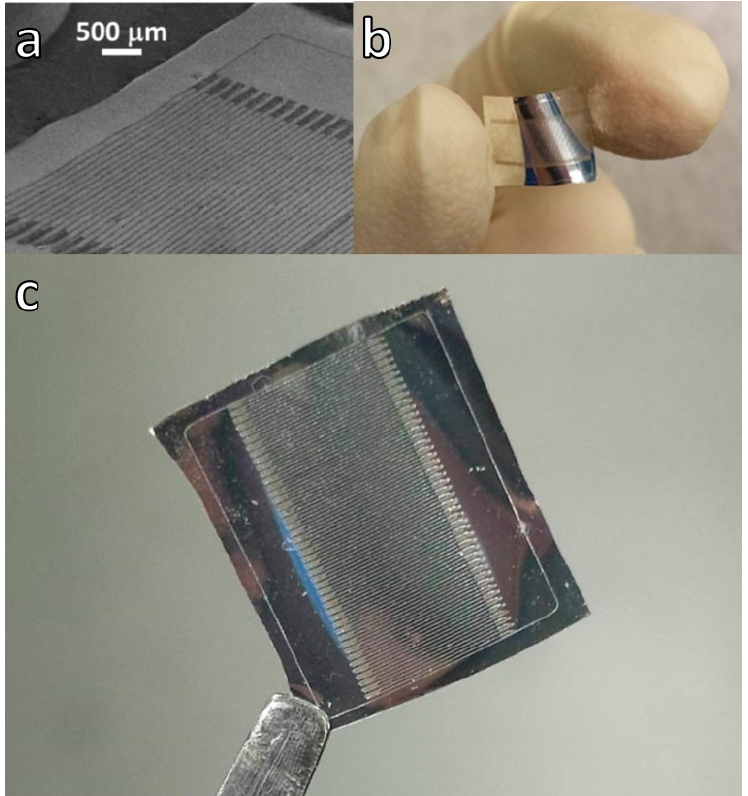
Figure 11. An inter-digit electrode composed of 45 pairs of digits with 30 µ m spacing and an 80 µ m width formed from a scanning laser dewetted Ag film deposited upon a Par-C polymer, imaged using ( a ) FESEM. The IDE can be removed from the glass slide as ( b , c ) a flexible and free-standing film.